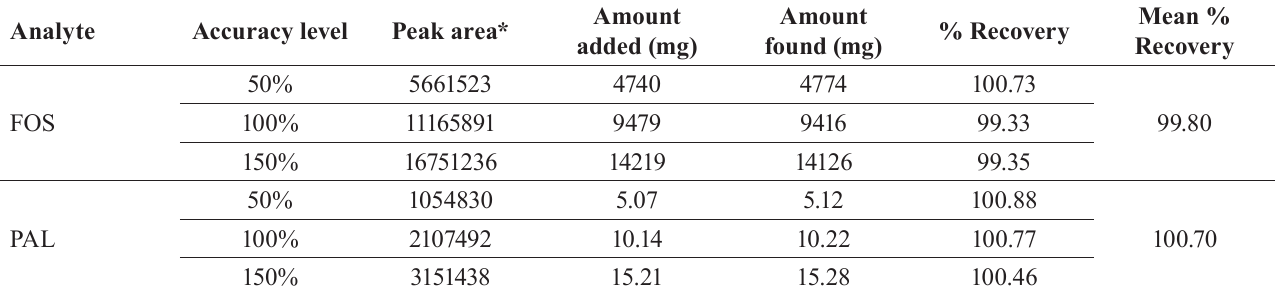
TABLE IV - Recovery study Analyte